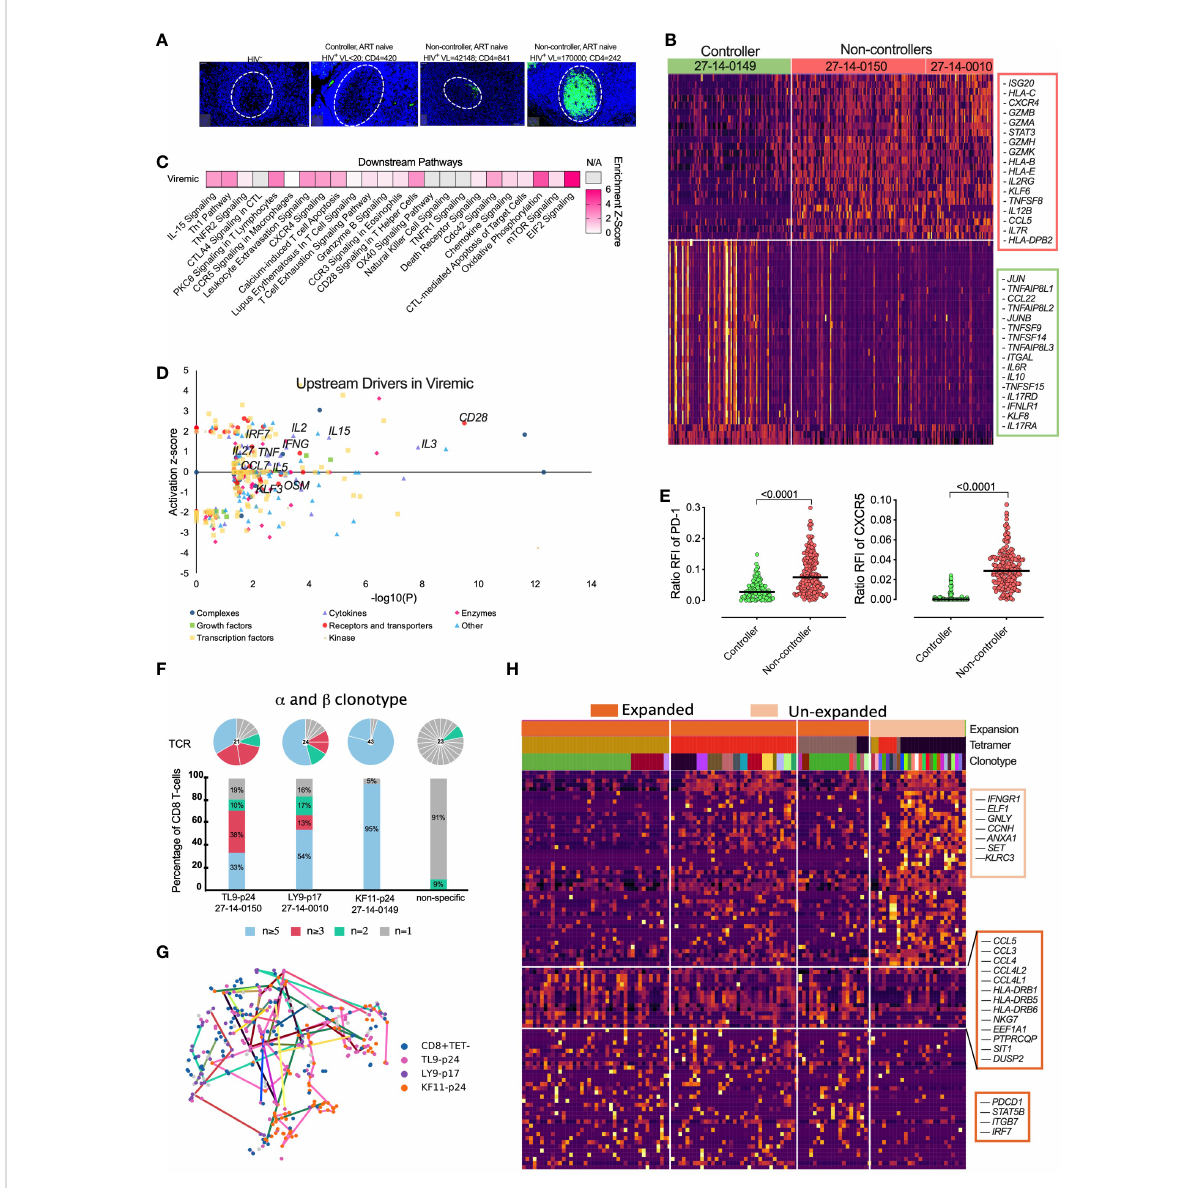
FIGURE 6 Natural HIV ‘ controllers ’ display reduced HIV speci fi c CD8 + T-cell cytolytic transcriptional signatures and PD-1 expression compared to viremic ‘ non-controllers ’ linked to expanded TCR clonotypes. (A) Fluorescence immunohistochemistry of HIV-24 protein (green) for 4 donors of HIV - , HIV + ‘ controller ’ and two HIV + ART - ‘ non-controllers ’ with plasma viral load and absolute blood CD4 counts listed above. (B) Heatmap showing differentially expression of 300 featured genes with selectively speci fi cally expressed genes marked (right) among 1,622 differentially genes (Supplemental Table S12). (C) Selected canonical pathways by Ingenuity Pathway Analyzer (IPA). (D) Upstream drivers of pathways signi fi cant by IPA of DEGs. For directionally annotated pathways, a Z -score is calculated to represent up- or downregulation of the driver or pathway. If a driver or pathway is not directionally annotated in IPA, or there are not enough genes in the list to calculate a Z -score, N/A is reported. See Supplemental Table S9 for the full IPA results. (E) Relative fl uorescence intensity (RFI) for PD-1 and CXCR5 expression for each HIV speci fi c CD8 + T-cell comparing ‘ controller ’ and ‘ non-controller ’ participants. (F) The TCR distribution of KF11-p24, TL9-p24 and LY9-p17 tetramer speci fi c CD8+ T-cells from 27-14-0149, 27-14-0150 and 27-14-0010, respectively (see Supplemental Table S2) with unique (n = 1), double (n = 2), triplet (n ≥ 3), and expanded (n ≥ 5) with bars colored in grey, green, pink and blue representing the fraction of cells belonging to groups of clonotypes with either 1, 2, 3-4 or more than fi ve clonotypes, respectively. Pie chart above each bar illustrates the composition of every